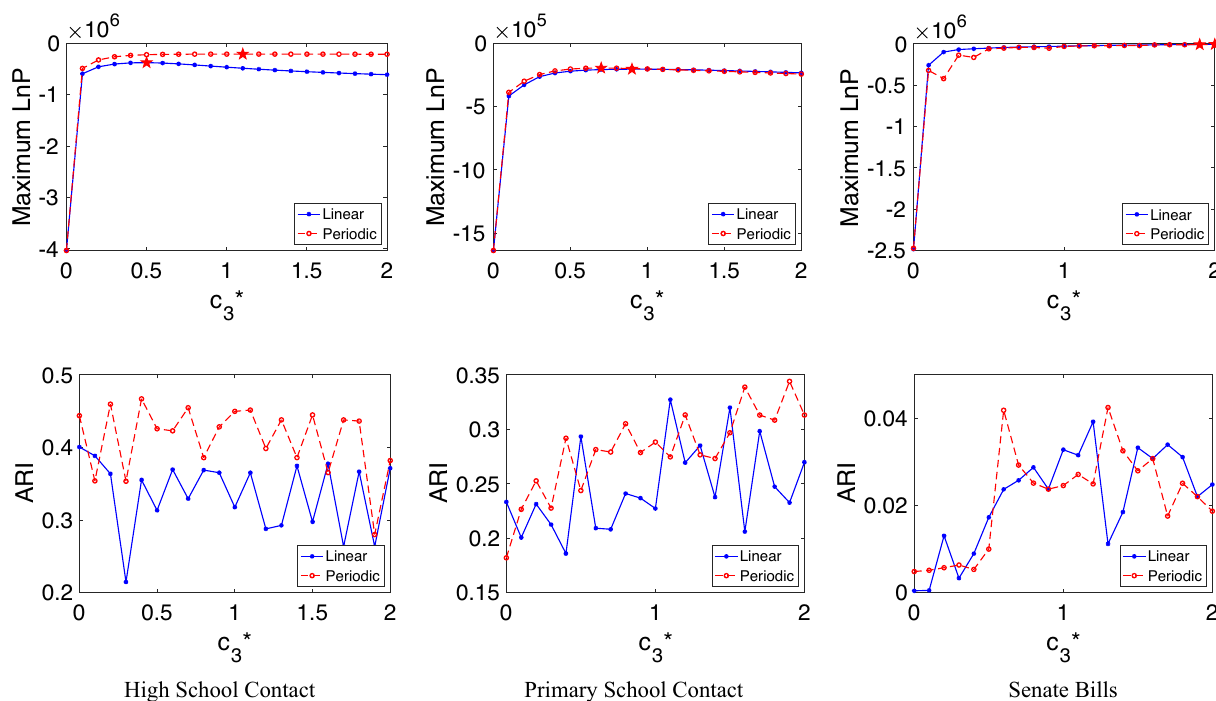
Figure 3. Model comparison experiments on the high school contact data (left), the primary school contact data (middle), and the senate bill data (right). Top row shows the maximum log-likelihoods of the linear and periodic embedding for different values of c ∗ 3 where pentagrams indicate maxima. Bottom row plots the Adjusted Rand Indices of K-means clustering based on the linear and periodic embedding for various c ∗ 3